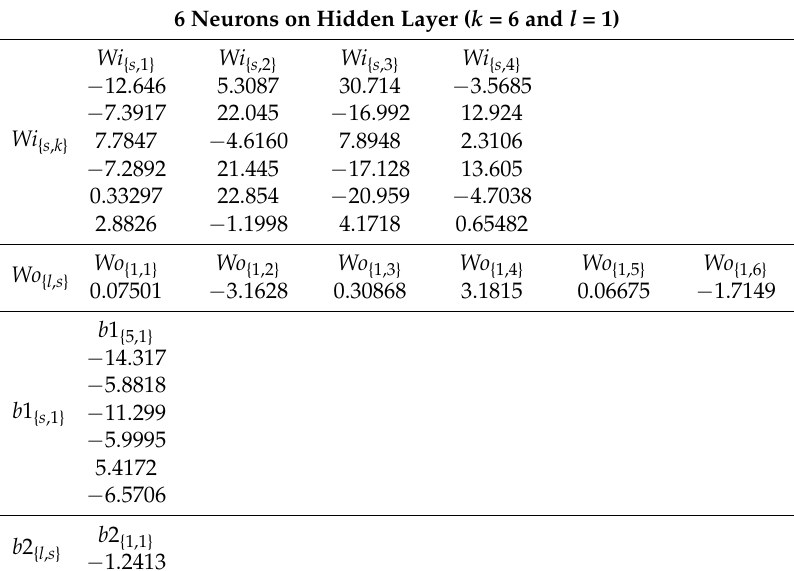
Table A5. Weights and biases for the ANN model predicting MDA concentration. 6 Neurons on Hidden Layer ( k = 6 and l =